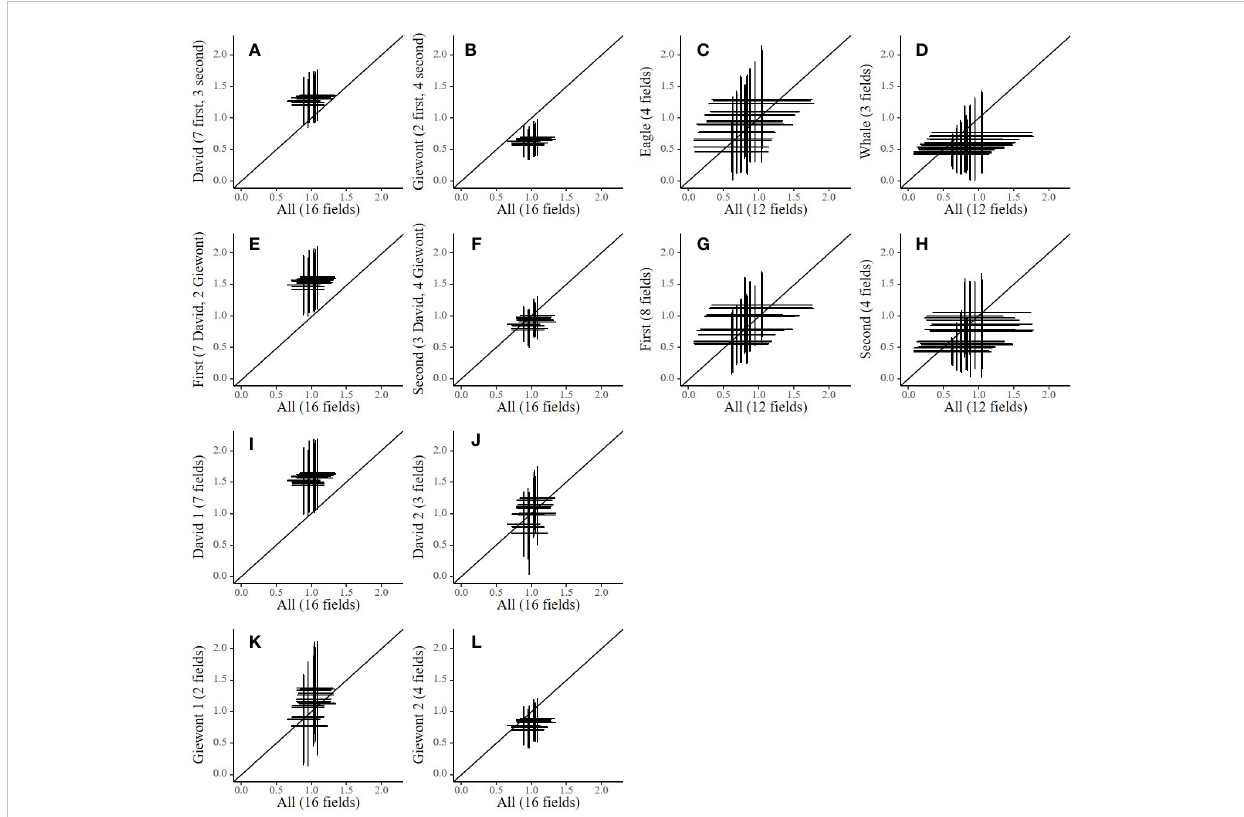
FIGURE 4 Plots showing the propagated simulation uncertainty (MAD) on yield output (t DM ha -1 ) at day 84 after planting for cauli fl ower (subplots A – H ) and day 38 after sowing for spinach (subplots I – L ) when splitting the calibration data into period and variety plotted as compared to calibrations performed on all available data. Every cross indicates output uncertainty (the mean plus or minus the MAD) calculated based on 5000 random samples from the posterior distributions with calibrations performed with multiple subsets of data for spinach (All, fi rst, second, Eagle and Whale) and cauli fl ower (All, David, Giewont, fi rst, second, David 1, David 2, Giewont 1 and Giewont 2). Every plot contains twenty crosses for conditions in which simulations were performed (ten years (2009 - 2018) in two different soil types (loam and loamy sand)). The number of fi elds included in the subset data are indicated in the y axis